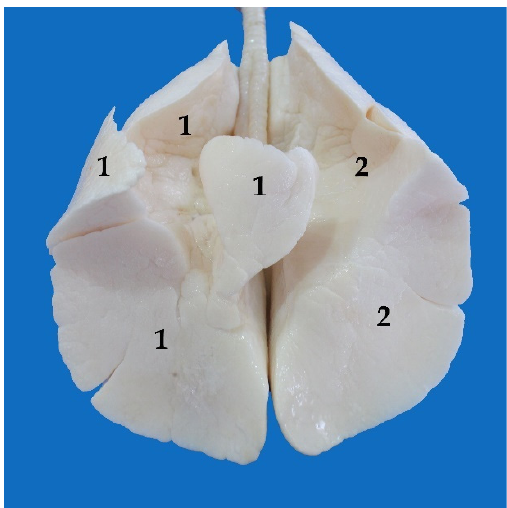
Figure 10. Ventral view of the lungs, washed with water and filled with compressed air: (1) right lung; (2) left lung.